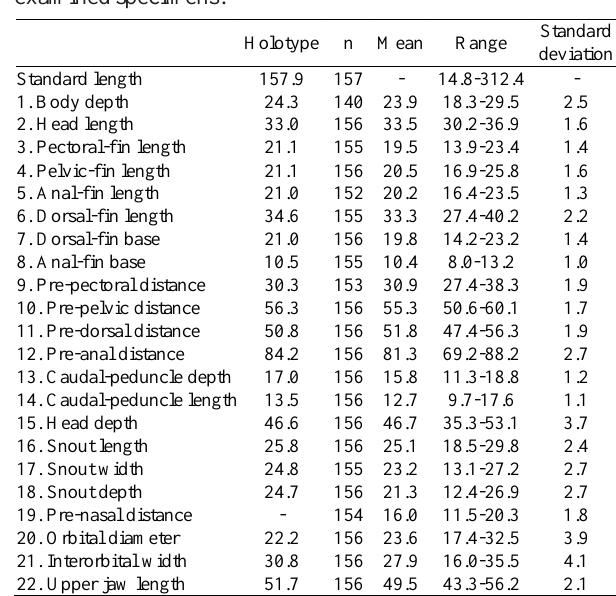
Table 5. Morphometric data of Hoplias curupira . Standard length in mm; values 1-14 are percents of standard length and values 15-22 are percents of head length. n = number of examined